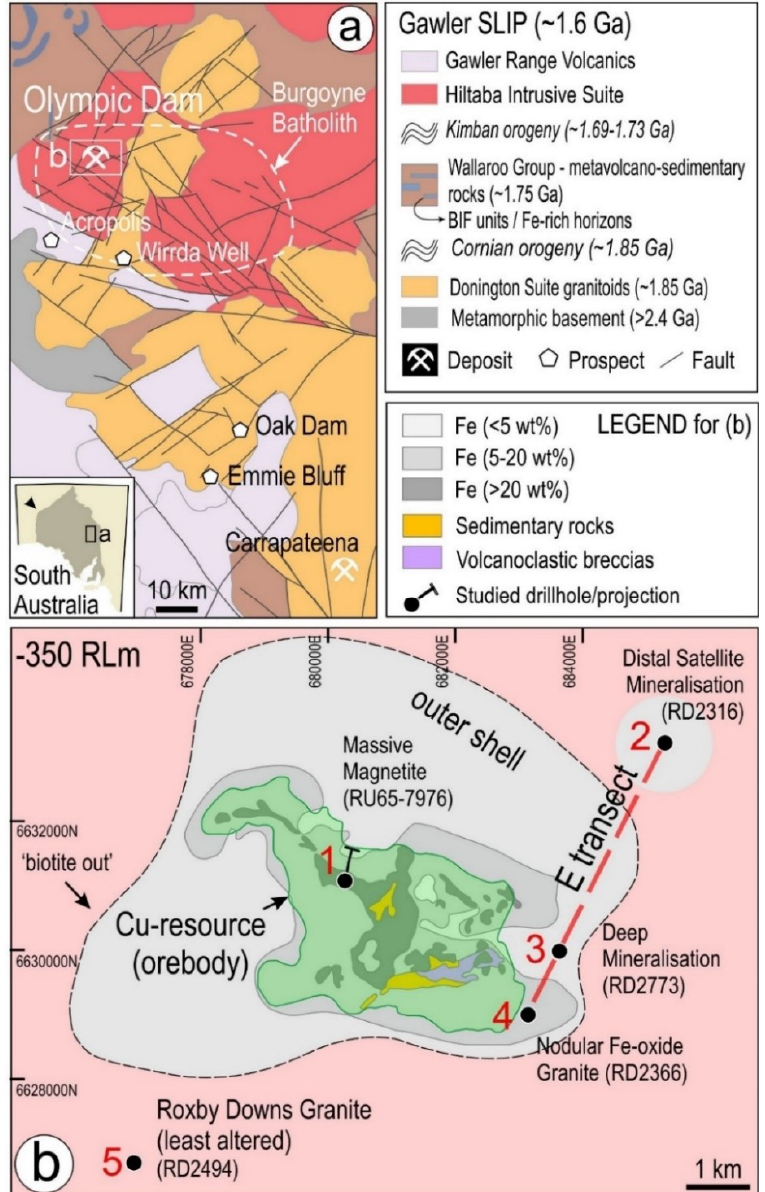
Figure 1. ( a ) Geological map of the Olympic Dam area outlining the main lithological units. Data sourced from https://map.sarig.sa.gov.au/ [49]. Inset shows location of this area in South Australia and extent of the Gawler Craton (arrowed). ( b ) Sketch of the Olympic Dam deposit showing main lithologies and projection of sampled drillholes (Table 2). SLIP-Silicic Large Igneous Province. Numbers 1–5 refer to sample locations (Table 2).